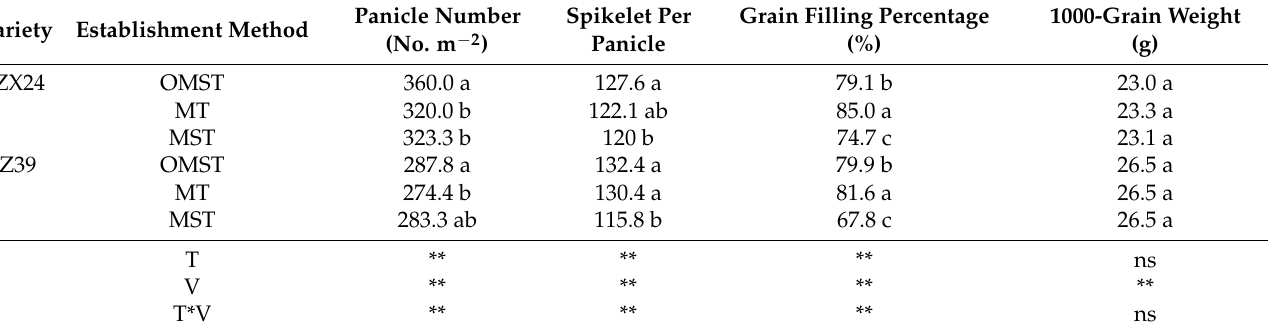
Table 2. The grain yield components under different rice establishment methods in